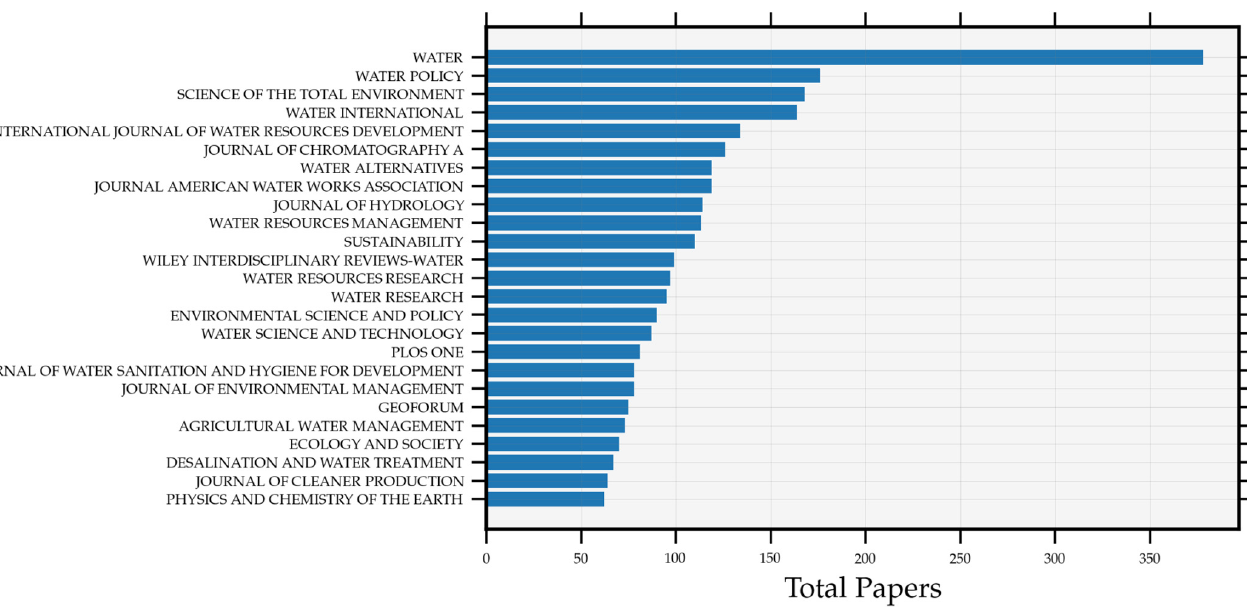
Figure 2. Number of papers published in the top 25 journals, 1990–2020. * It is worth pointing out that while this figure provides the list of the top 25 journals, the number of journals publishing research on/related to the HRtWS is quite large. For instance, in 2020 alone, over 770 different journals published at least one paper on topics related to the HRtWS.